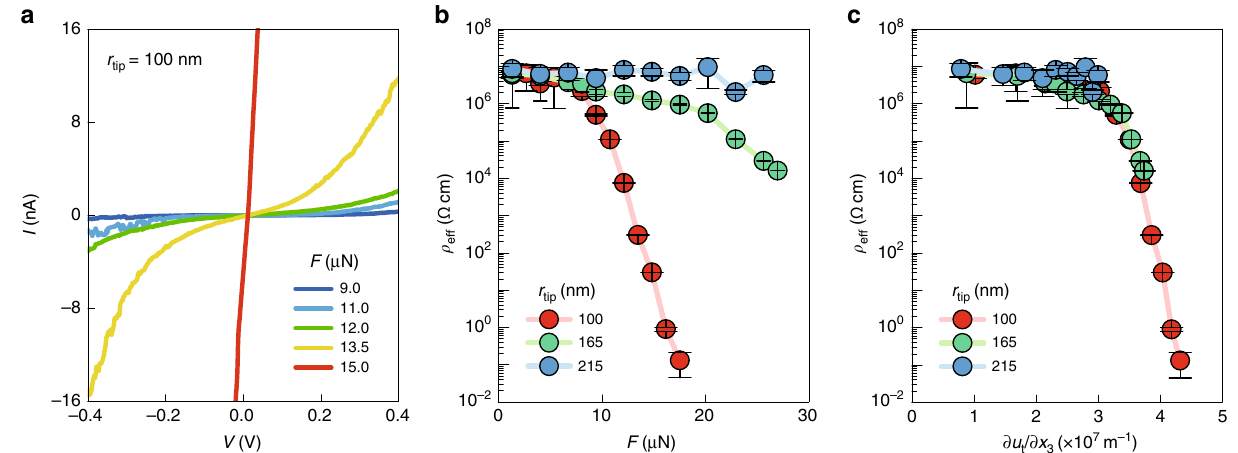
Fig. 3 Colossal fl exoresistance effect in ultrathin STO. a Current ‒ voltage ( I – V ) curves obtained by conductive AFM measurements in a 10-unit cell-thick STO fi lm upon application of various tip loading forces F . Five representative curves are shown here. b Effective resistivity ( ρ eff ) as a function of F . c ρ eff as a function of the AFM-tip-induced strain gradient ∂ u t / ∂ x 3 . Error bars denote standard deviations of the fi tted resistivity. Source data are provided as a Source data fi le.